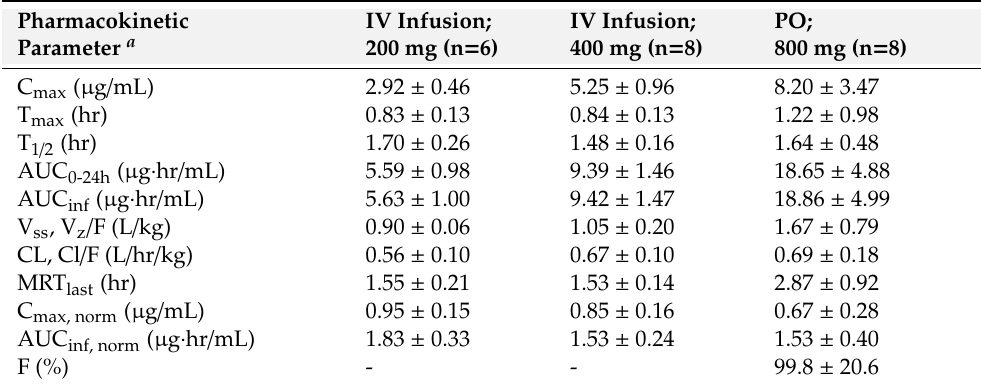
Table 4. Phase 1 study: summary of delpazolid pharmacokinetic parameters. IV infusion 400 mg and